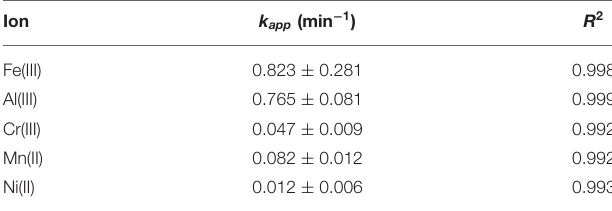
TABLE 4 | Values of Langmuir and Freundlich constants, related to adsorption of Cr(III) ions on SBH-A (800mg L − 1 ) at pH 5, time of contact 24h.